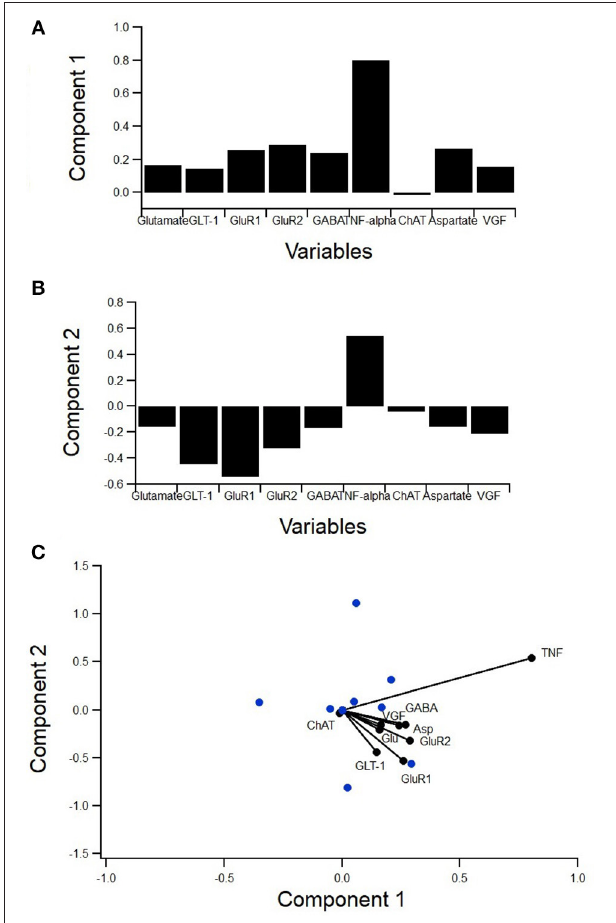
FIGURE 5 | PCA to determine variance contribution of non-inflammatory regulators of astrocytes. Biplot showing variable contributions to the first two PCA-determined components (A) broken down to the first two components and the comprising variables (B,C) . Component 1 accounted for 55% of the variance and was almost completely comprised of TNF α (B) . Component 2 accounted for 17% of the variance and was mostly comprised of GABA and aspartate (C)